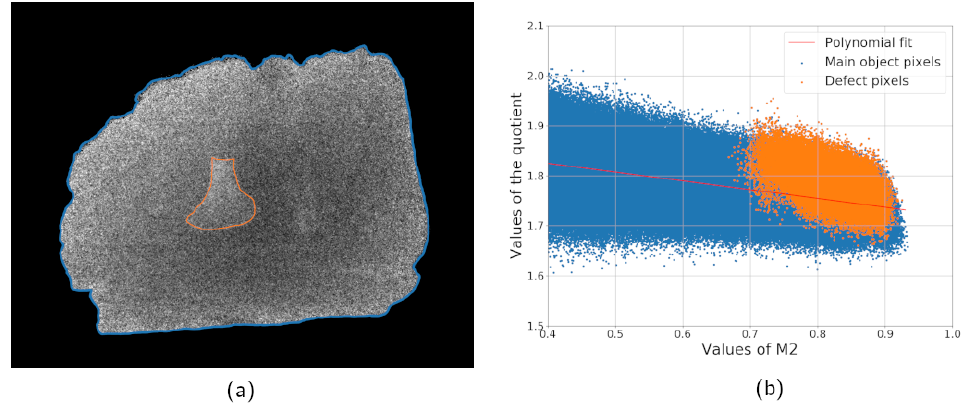
Figure 3. Sample scan with low exposure (0.5 s per projection): combined image computed according to Equation (5) ( a ) and the dependency of its values on the single projection intensity ( b ).